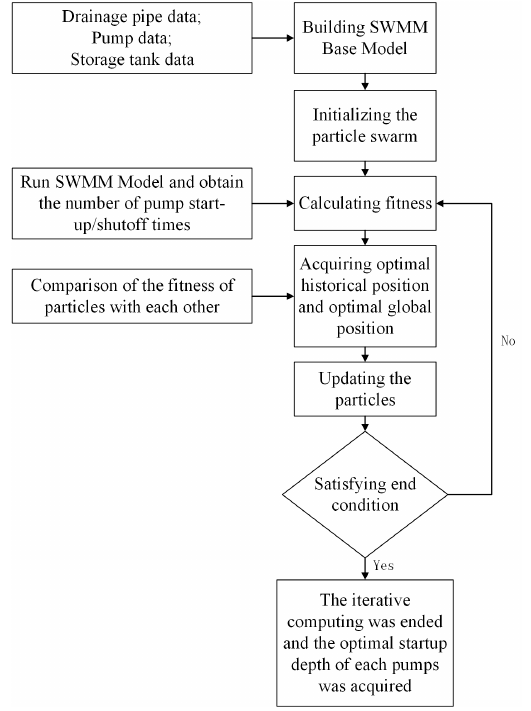
Figure 2. The optimization process for the start-up depths of the pumps.